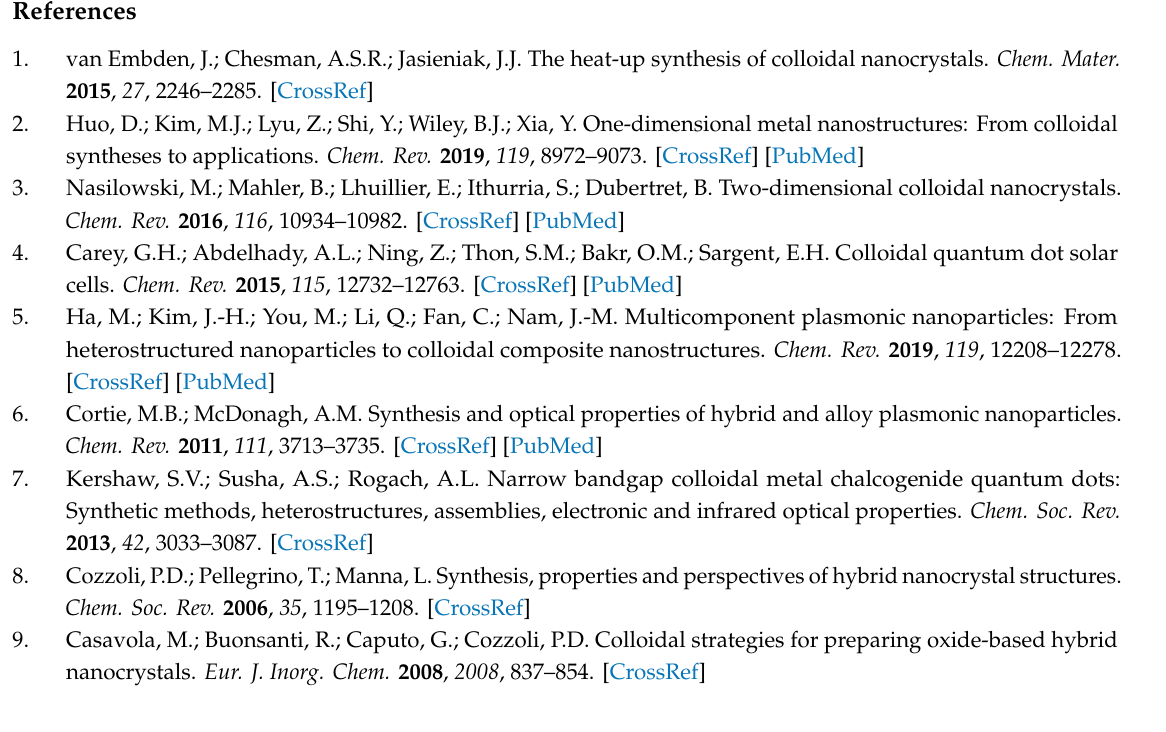
Supplementary Materials: The following are available online. Figure S1: FTIR spectra of neat oleic acid and oleylamine. Figure S2: TEM micrograph of oleic acid-capped TiO 2 NCs after injection of [Pb 2 + ] = 0.01 M, [HMDS] = 0.002 M at 100 ◦ C. Figure S3: Time-resolved photoluminescence decay at 460 nm ( λ and PbS / TiO 2 hybrid nanostructures. Figure S4: Gaussian deconvolution of photoluminescence spectra ( λ ex = 375 nm) in the visible range and in the NIR range of TiO 2 NCs and PbS / TiO 2 hybrid